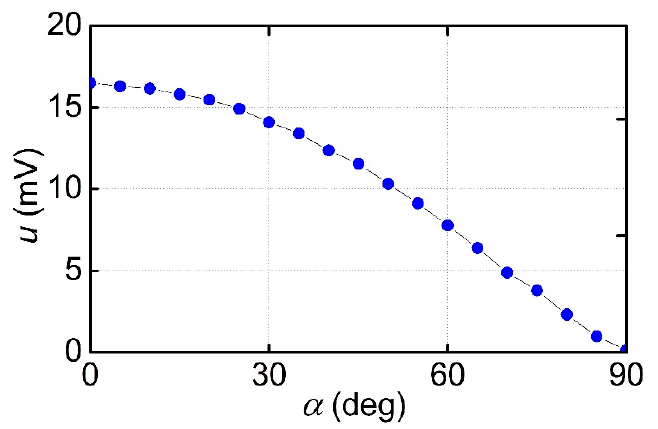
Figure 7. Dependence of the ME voltage at the resonance frequency with H = 3.18 kA / m and h = 17.5 A / m on the angle α between the H -field and the Ni-wires.